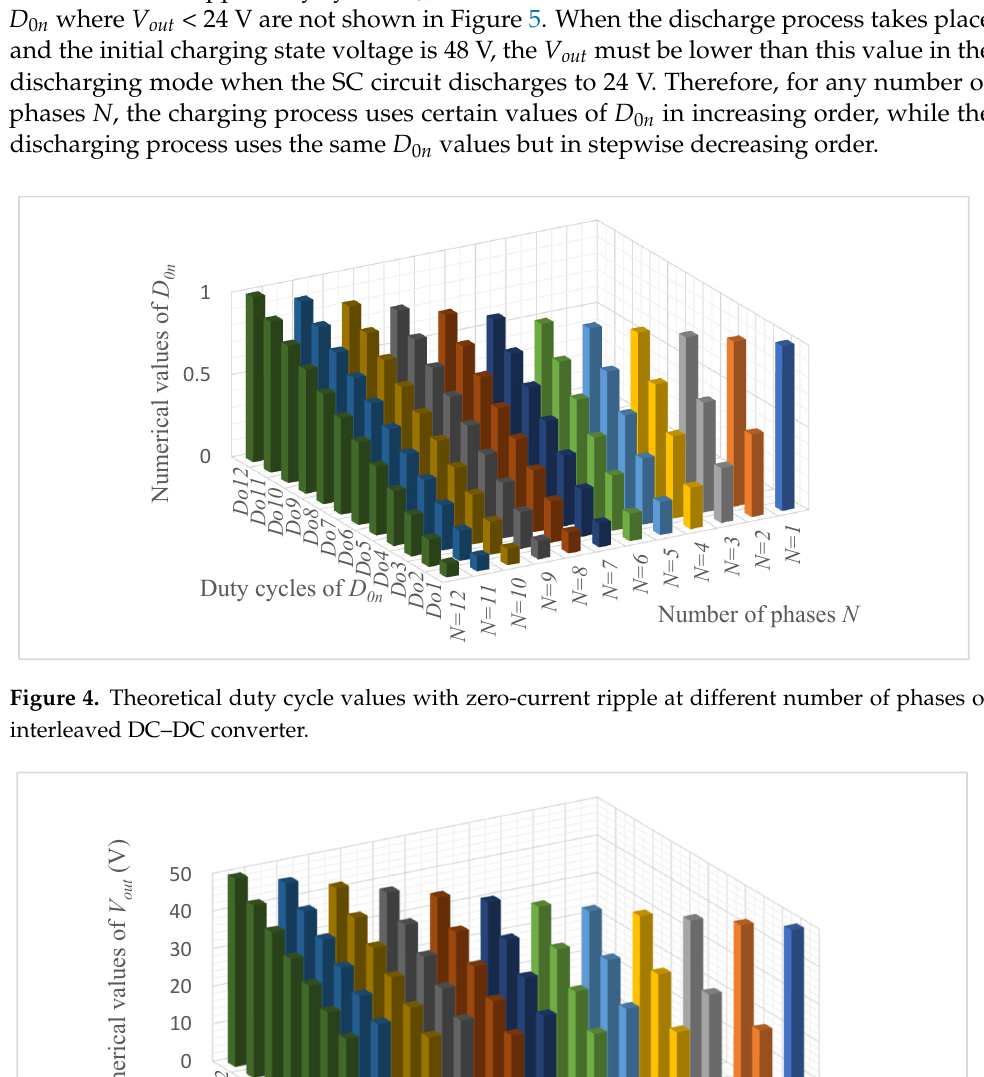
Figure 4. Theoretical duty cycle values with zero-current ripple at different number of phases of interleaved DC–DC converter.